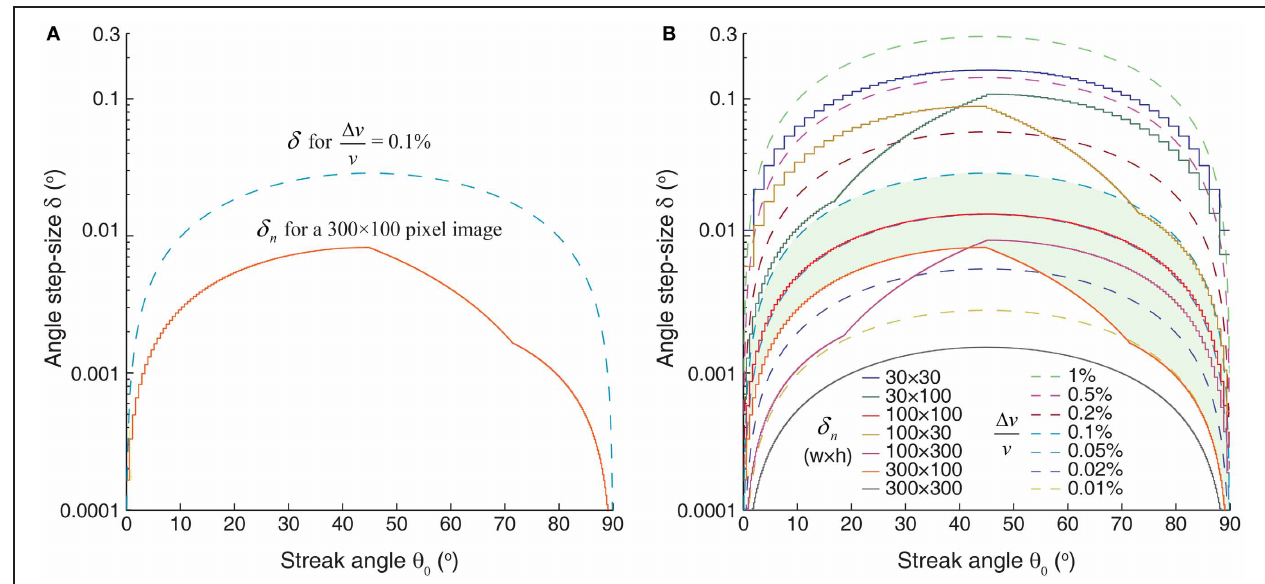
imposed on δ by the required (cid:2) v / v (dashed lines) and δ n for different image sizes (solid lines). Green shaded area corresponds to the δ values as shown in (A) . In order to achieve a given (cid:2) v / v sensitivity, δ values should be below the respective (cid:2) v / v curve,butabovethe δ n curveasdetermined bytheimagepixel dimensions. Note that the tolerance in the angle step-size values is highest at 45 ◦ streak angle. For agiven imagesizeanangle step-size value belowthe solid line is not resolvable. δ n calculations are based on a space-time image with 1.19 μ m/pixel spatial resolution and inter-streak distance of 4 μ m ( ∼ 3.3